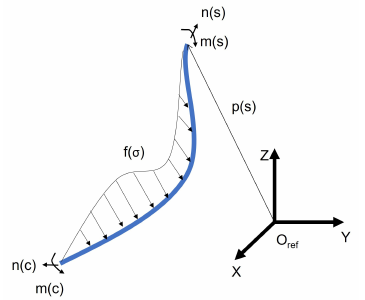
Figure 17. Section of a rod to explain the